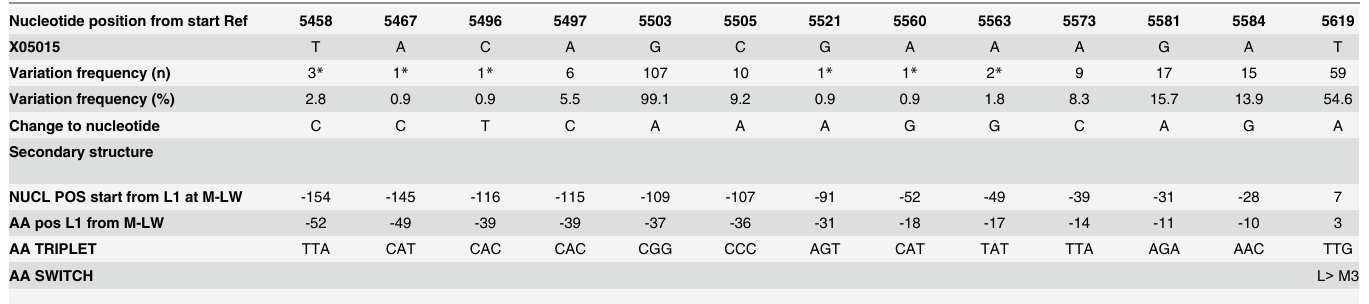
Table 3. Non-synonymous nucleotide sequence variations of HPV-18 L1.